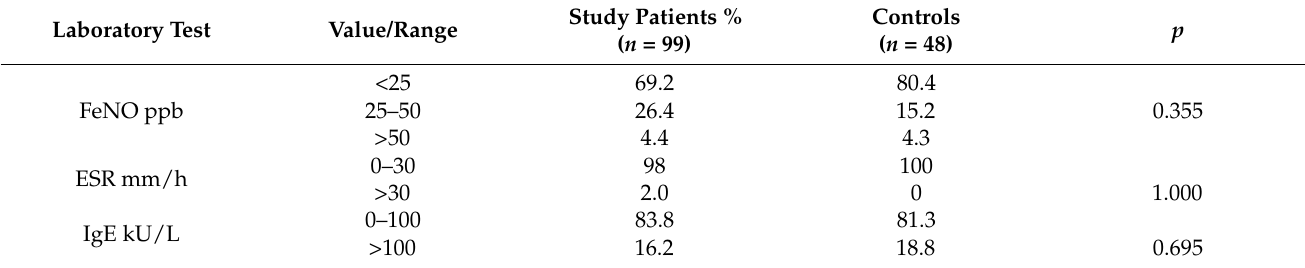
Table 1. Laboratory test results of the study patients and the controls (FeNO = fractional exhaled